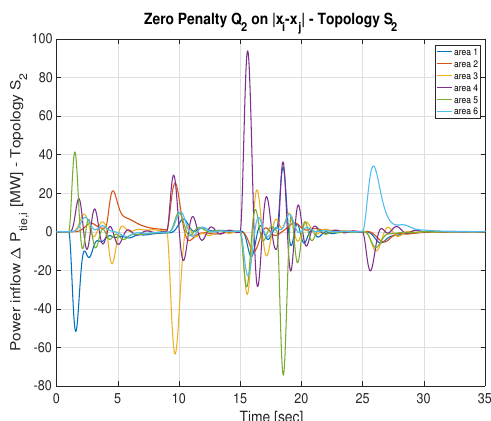
Figure 15. Total power inflow deviation ∆ P tie , i response for i = 1, · · · ,6, topology S 2 , control tuning with Q 2 = 0, uncertain parameters.